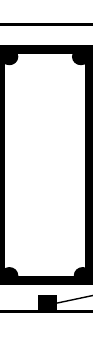
Figure 21. Schematic of application of prestressed NSM rods in cross-section ( left ) and inside the groove ( right ) for the flexural strengthening of rectangular beams.